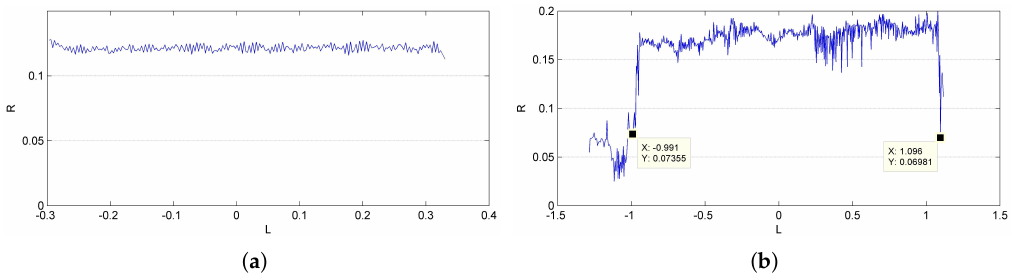
Figure 11. Outline of the reconstructed point cloud for ( a ) cylinder model and ( b ) packing